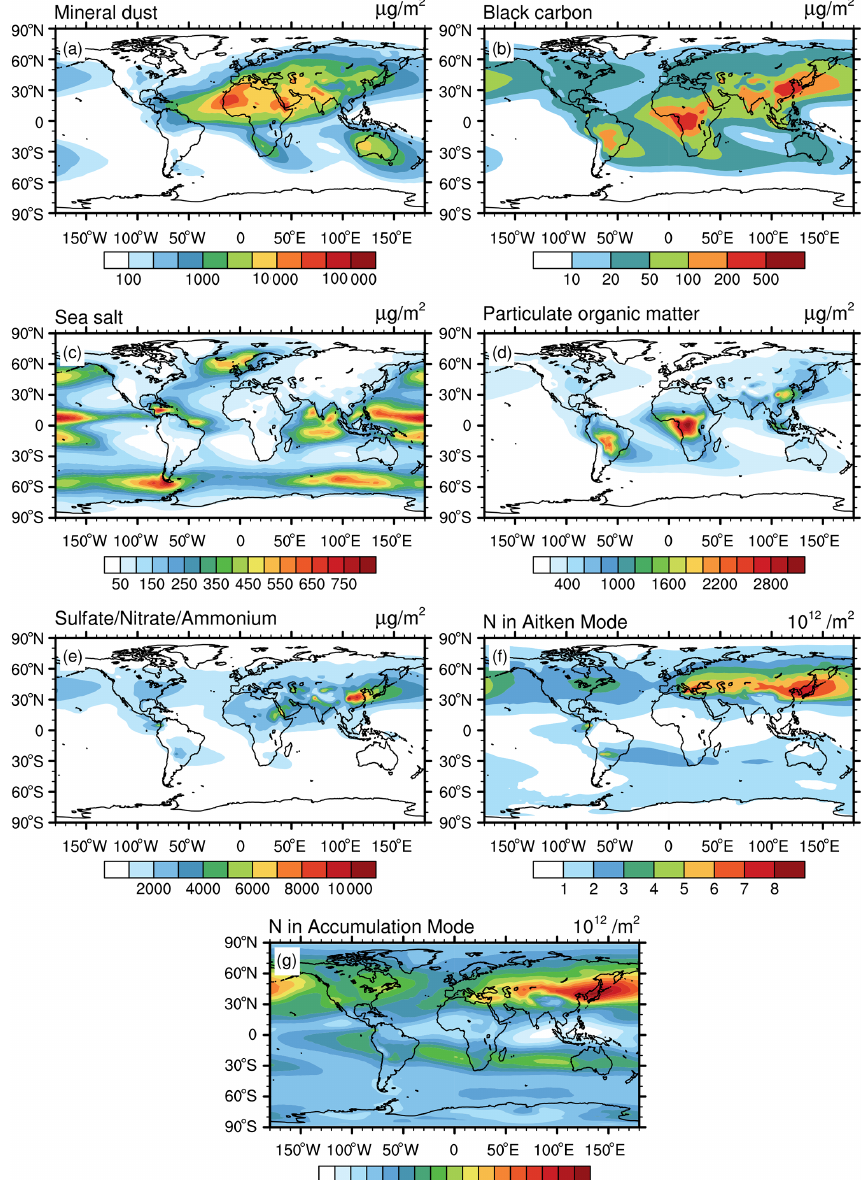
Figure 3. The same as Fig. 1 but for the middle troposphere (from ∼ 700 to ∼